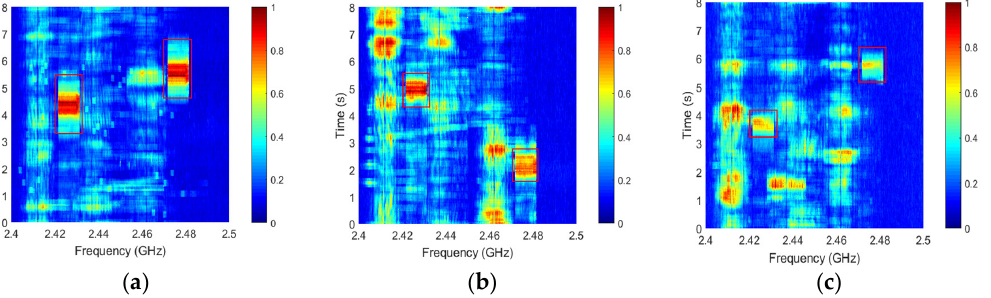
Figure 13. Normalized time–frequency diagrams after filtering for two UAVs outdoors at distances of ( a ) 500 m, ( b ) 1500 m, and ( c ) 2500 m.